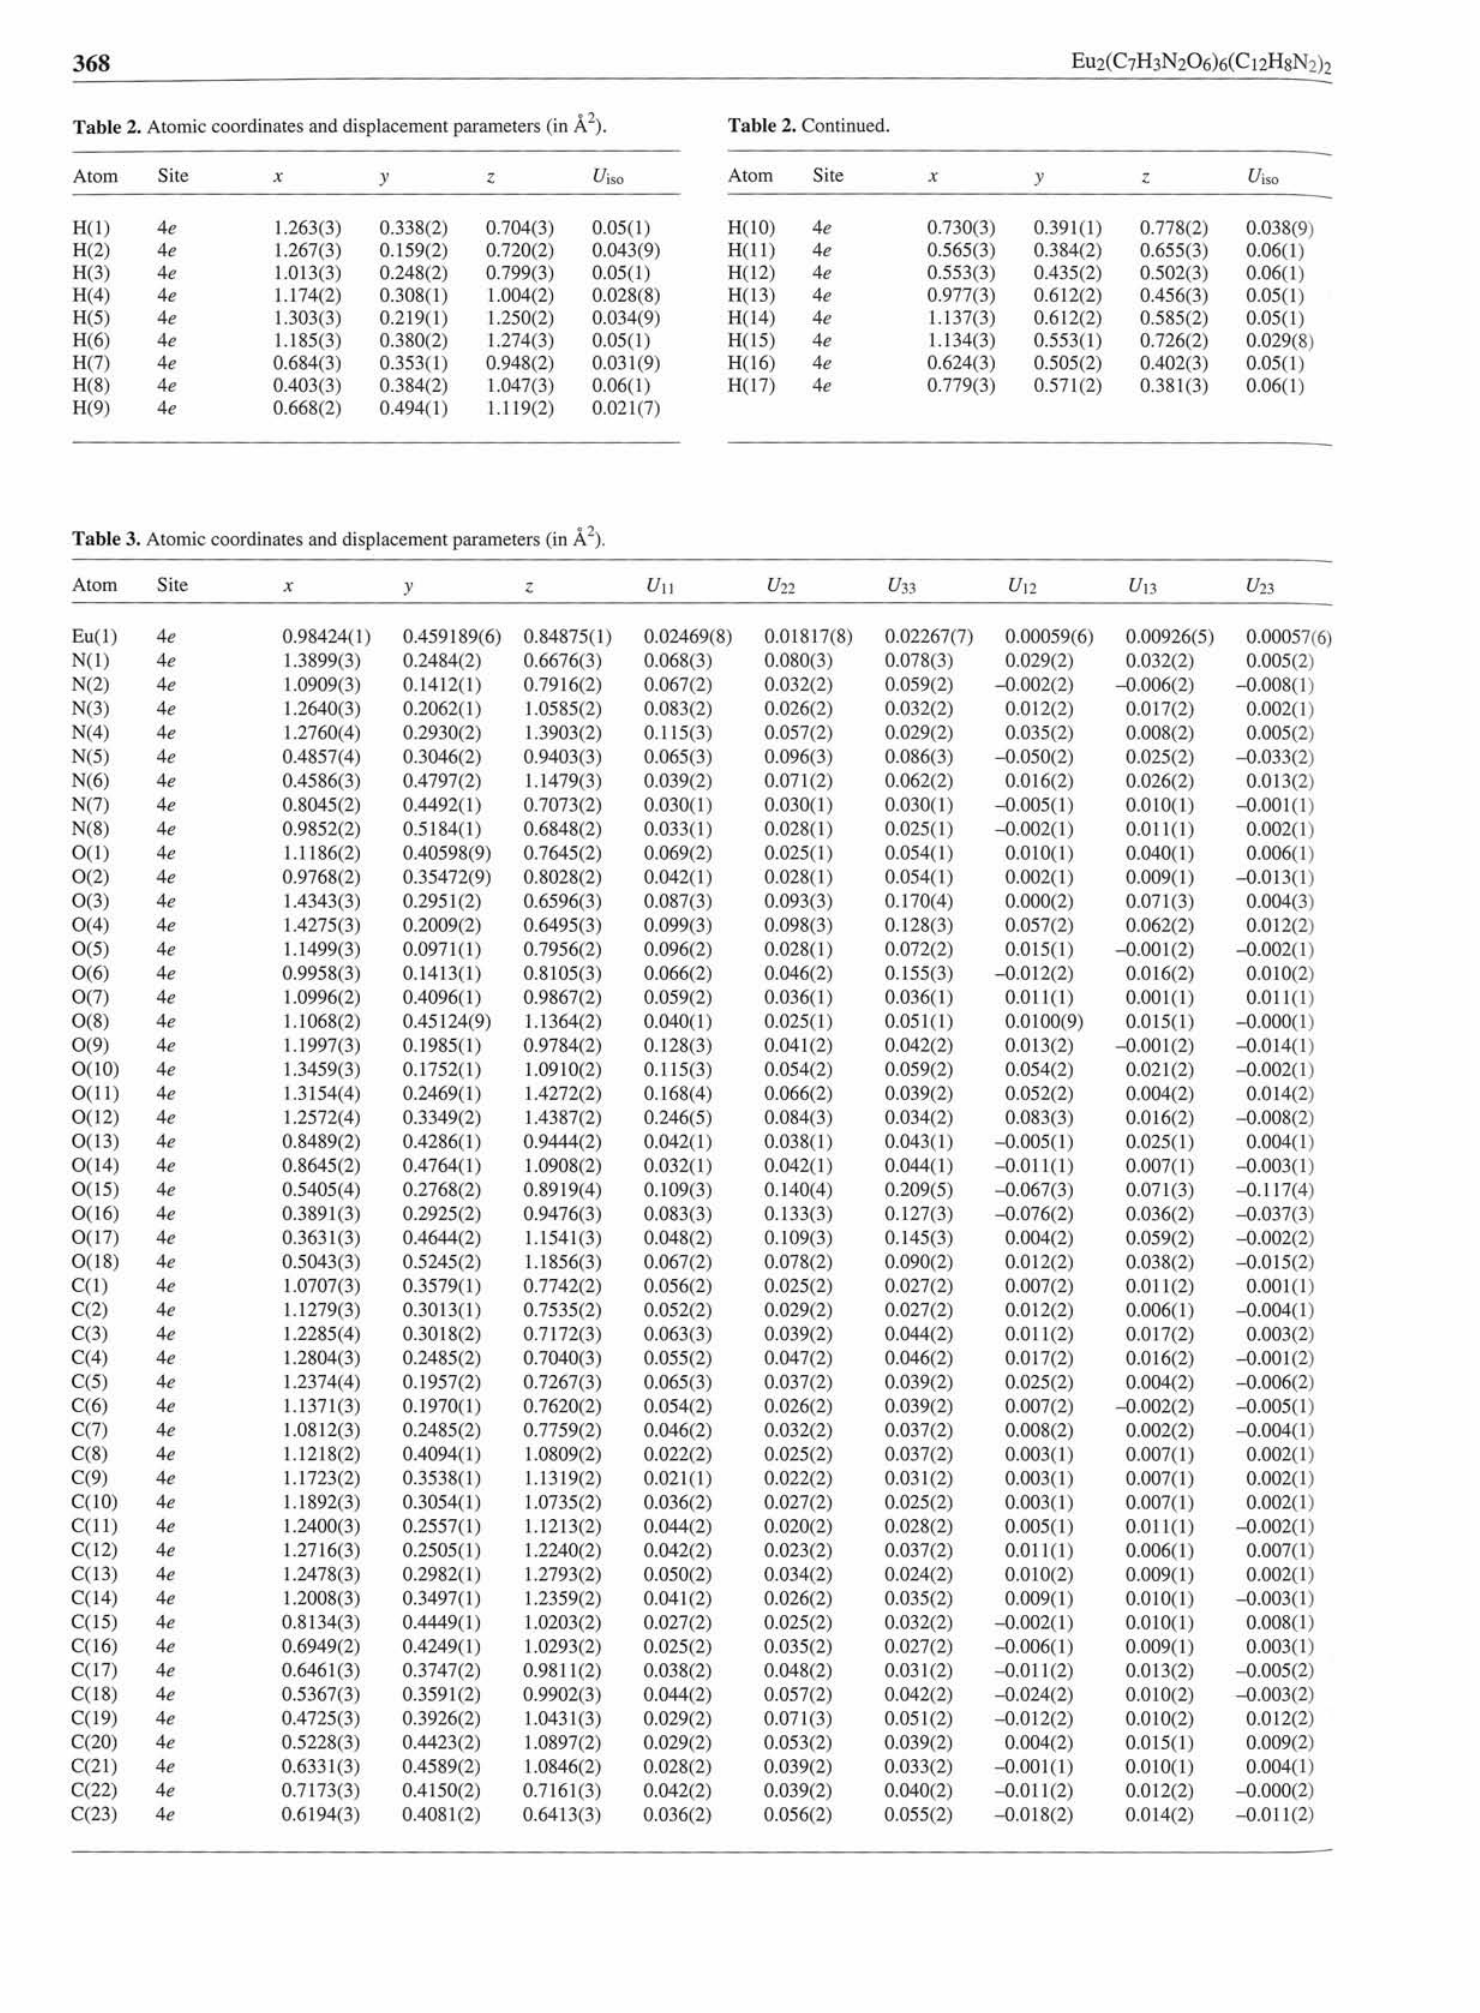
Table 2. Atomic coordinates and displacement parameters (in Á 2 ).